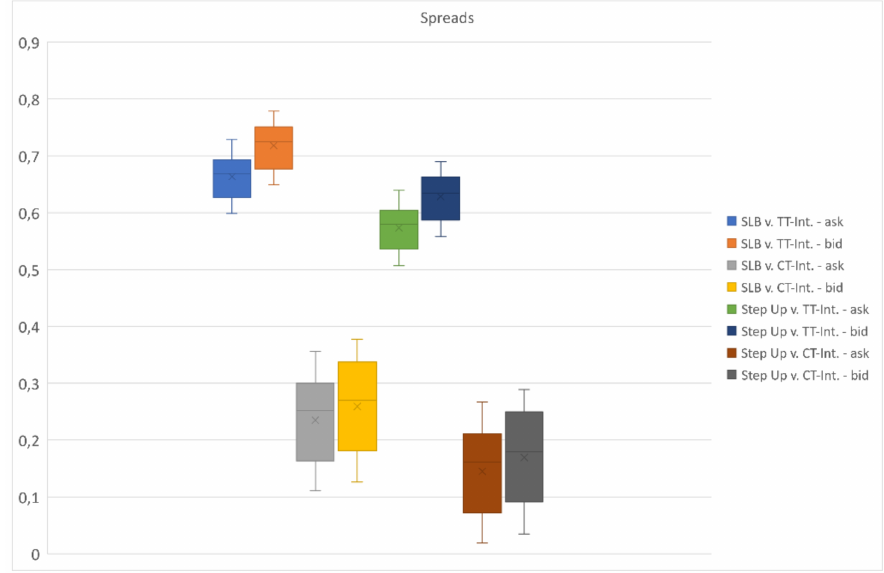
Figure 4. Distribution of spreads within certain issues (in